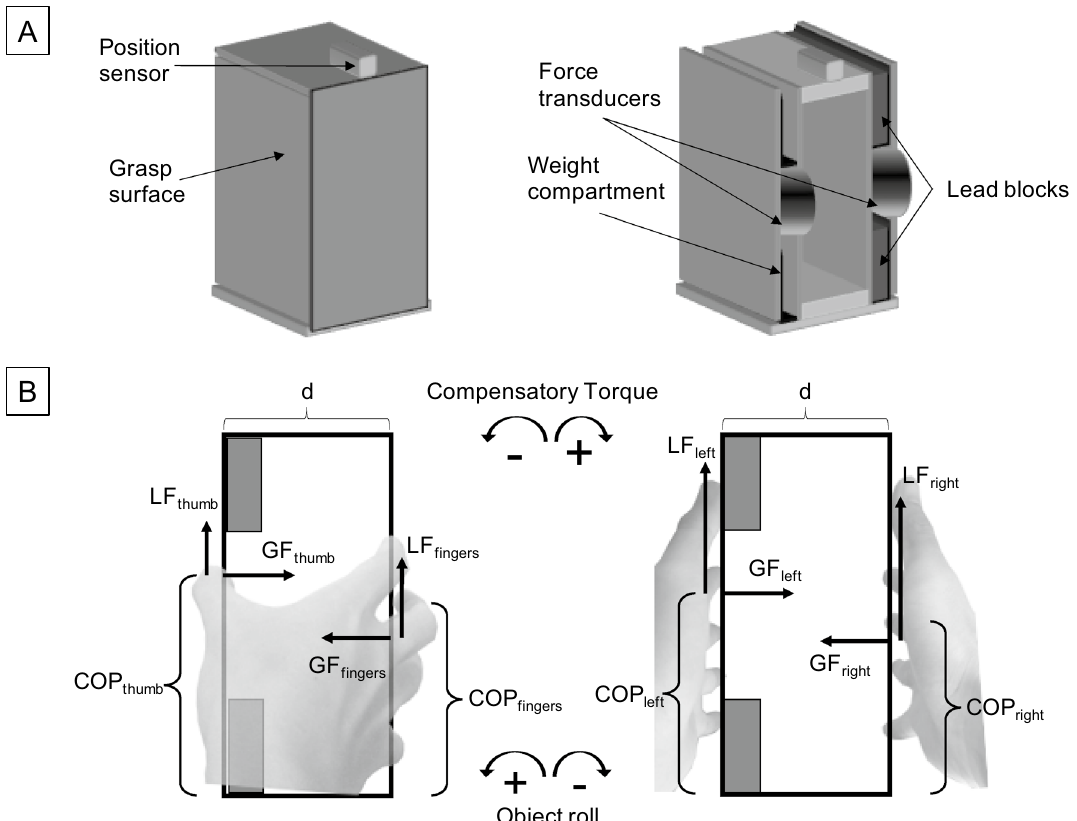
Figure 1. Experimental Apparatus. ( A ) Physical appearance of the object as presented to the participants and the inner components. ( B ) Schematic layout of the grasped object showing the total forces produced by the digits on each side and the direction of resultant compensatory torque and object